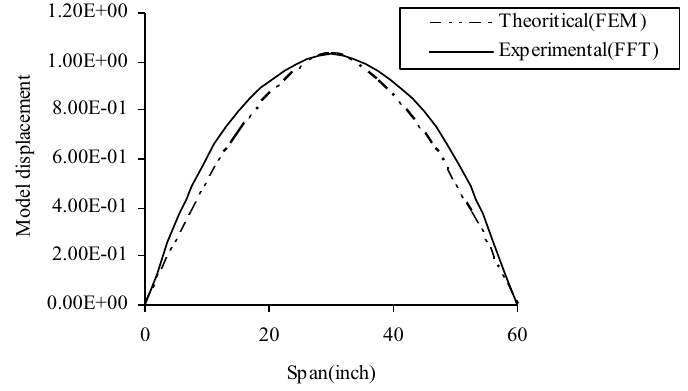
Fig. 7. 2nd mode (lateral) shape of curved box